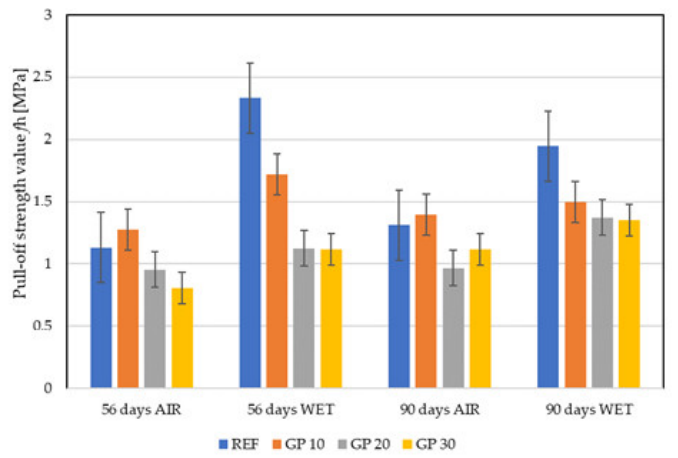
Figure 5. Average pull-off strength f h of the near-surface layer f c .